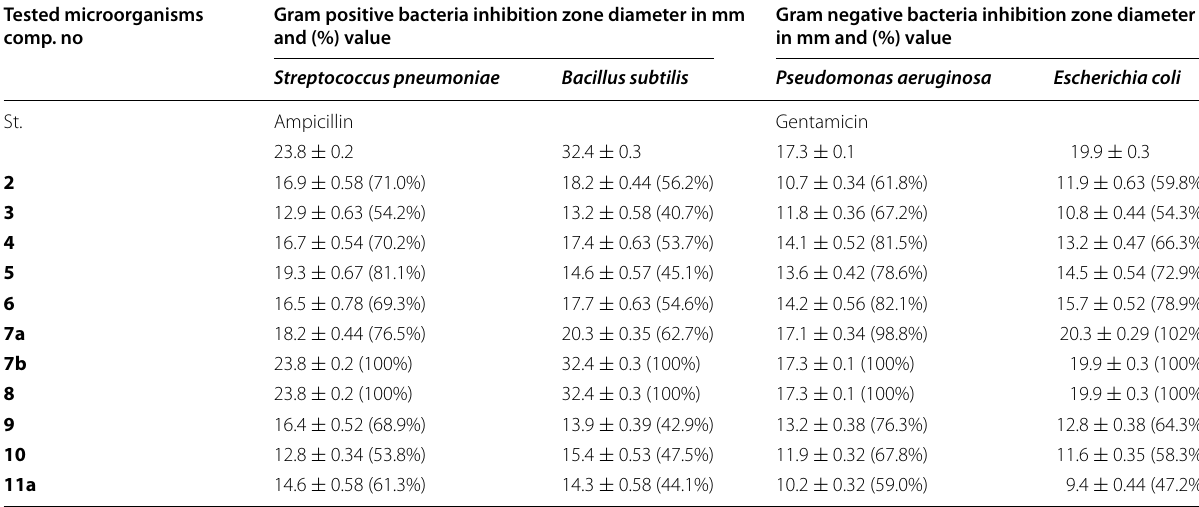
Table 1 Antibacterial activity of synthesized compounds (zone of inhibition in diameter in mm) Tested microorganisms Gram positive bacteria inhibition zone diameter in mm comp. no and (%) value